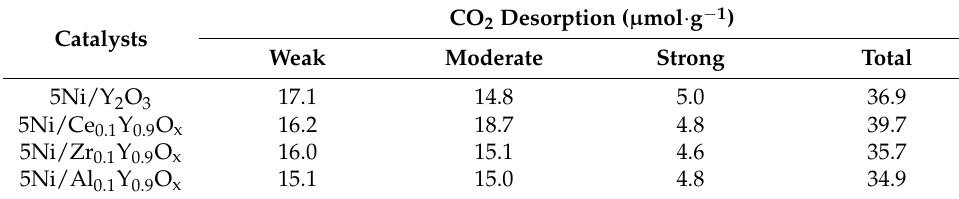
Figure 10. CO 2 -TPD profiles of the reduced catalysts. Table 7. CO 2 desorption amount of the reduced catalysts .